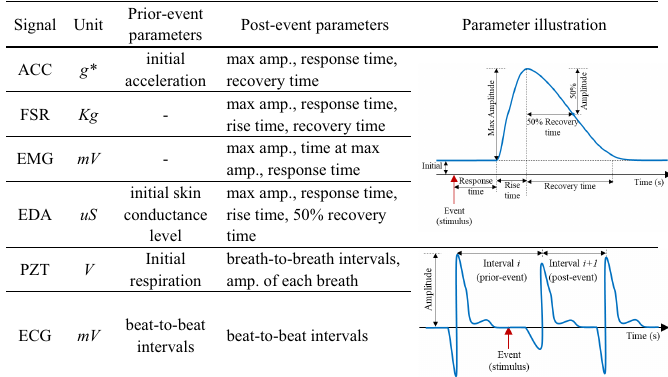
Figure 7 Characteristic parameters of each physiological signal